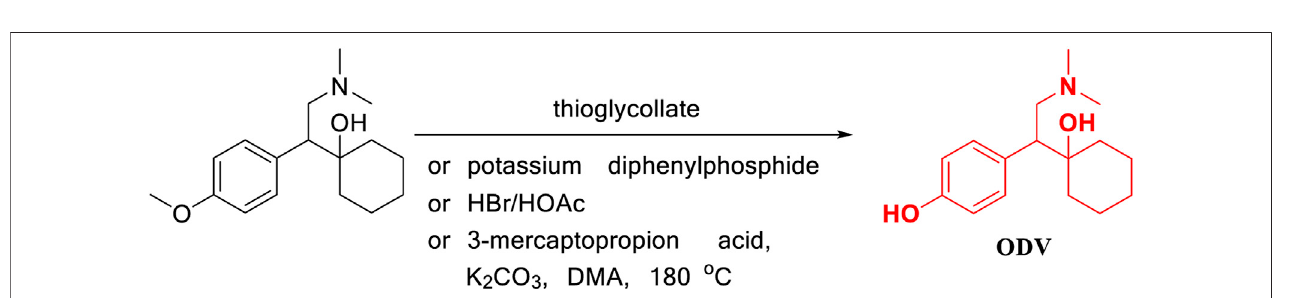
FIGURE 4 | Removal of phenol methyl from